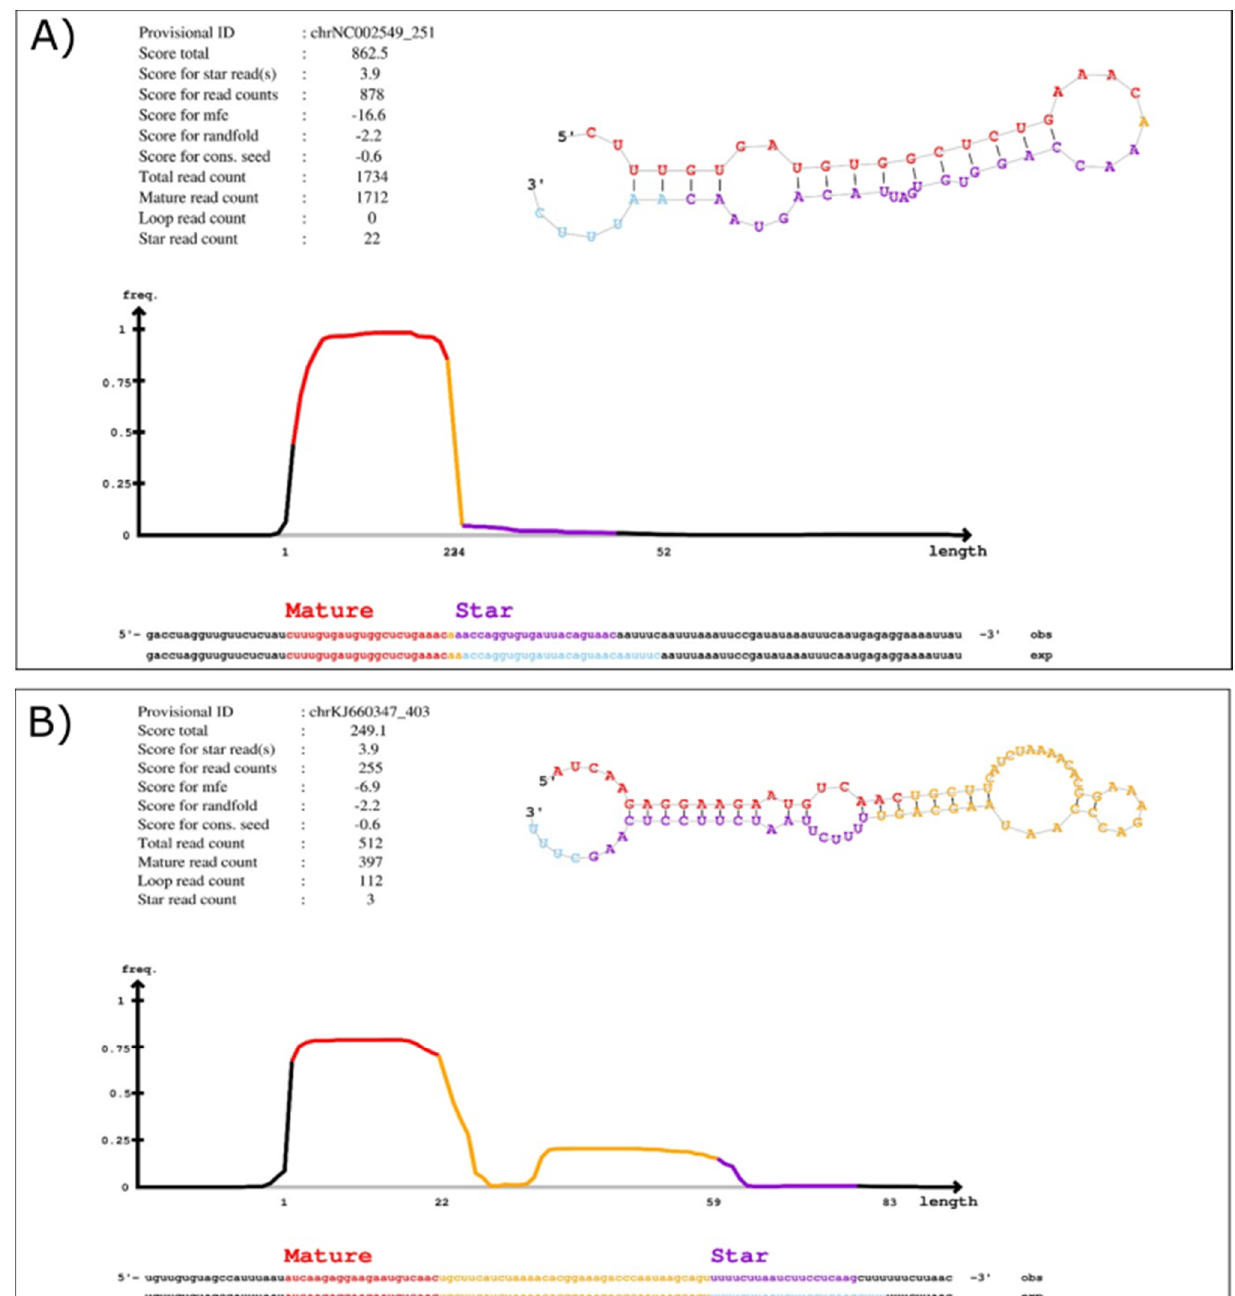
Figure 1. sRNA-Seq and miRDeep2 analysis of Huh7 cells infected with EBOV unveiled two novel EBOV microRNAs. EBOV-miR-MAY-251 ( A ) and EBOV-miR-MAK-403 ( B ) microRNAs were detected in Huh7 cells infected with Mayinga or Makona EBOV variants, respectively. In each panel, the upper left table lists the miRDeep2 score breakdown for the reported microRNAs, along with the read counts for the mature, loop and star sequences [37]. At the upper right of each panel are illustrations of the microRNA precursor secondary structure predictions. The bottom density plot highlights the read distribution in the predicted precursor sequence. The position of the star strand, as expected from Drosha/Dicer processing, is shown in light blue, while the star consensus position, as detected in the sequencing data, is shown in purple [37]. The complete data for the alignment are in Supplementary File S1.